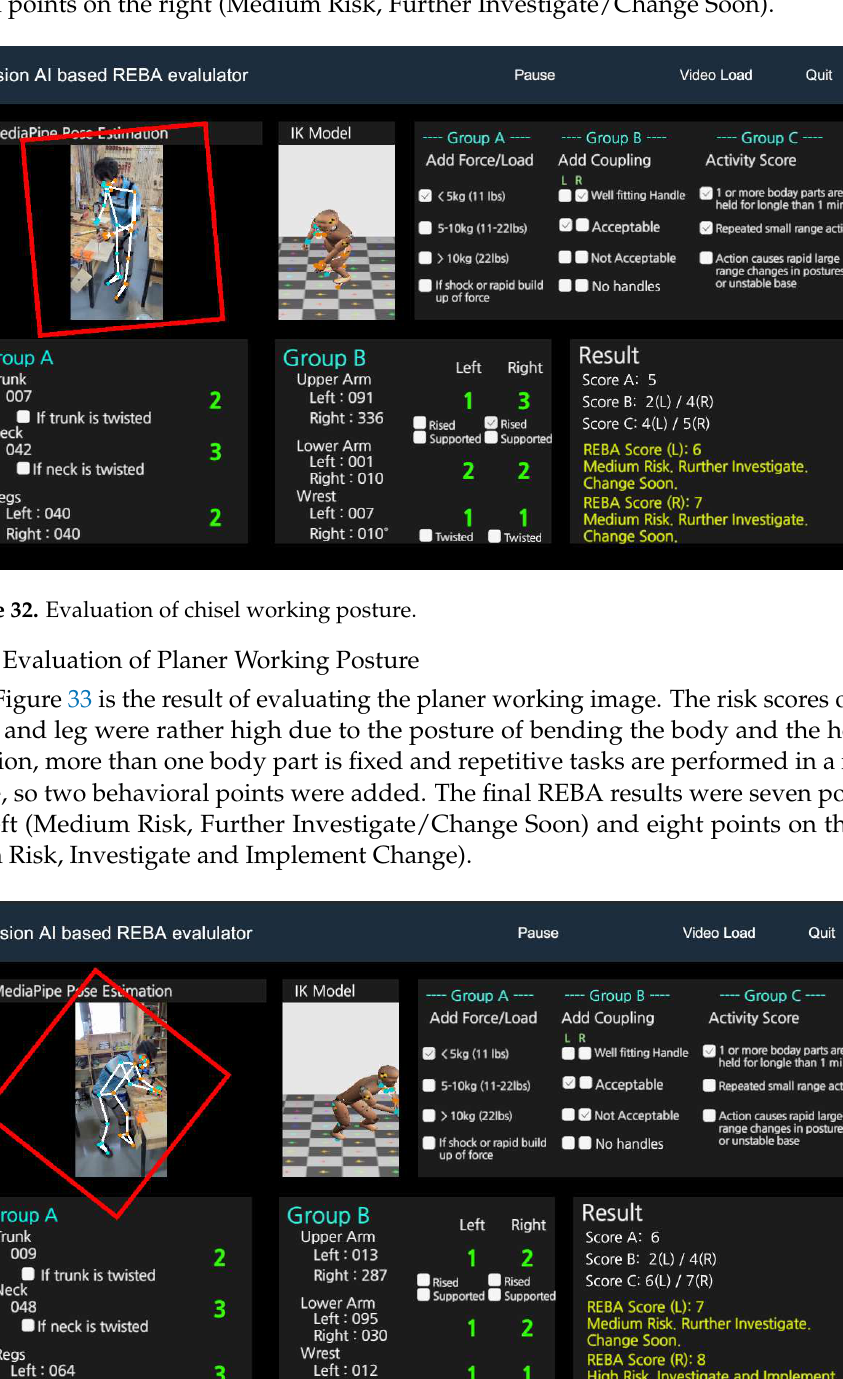
Figure 31. Evaluation of saw working posture.